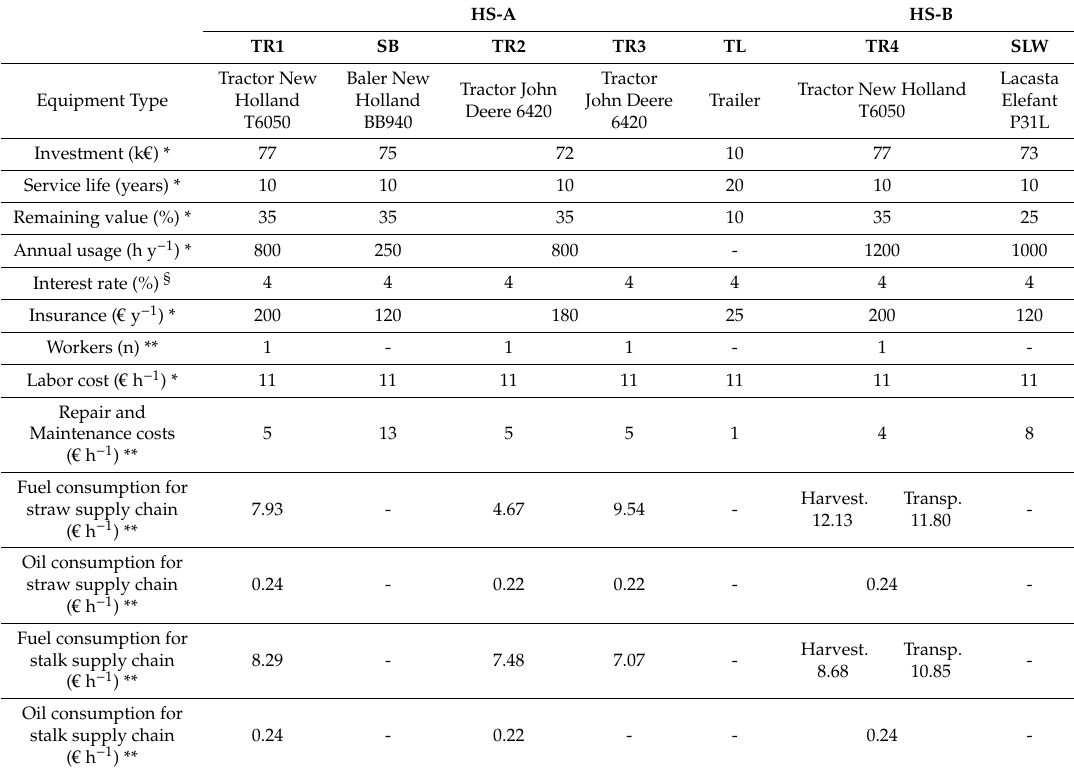
Table 1. Base-case parameters used for the economic analysis of the harvesting and transport of maize stalks and cereal straw using both baling harvesting system (HS-A) and self-loading harvesting system